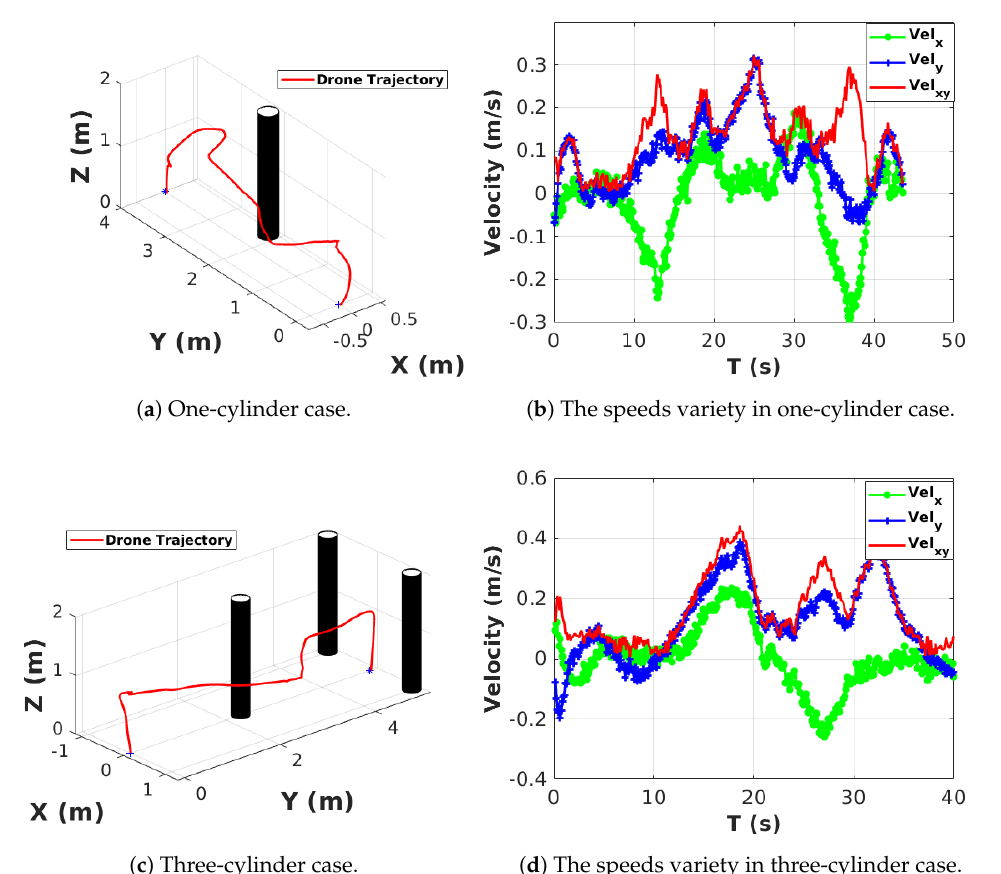
Figure 7. Real flight experiments. The green and blue lines are the speeds in the x and y direction while the red solid line is the sum of the absolute speeds in the x and y